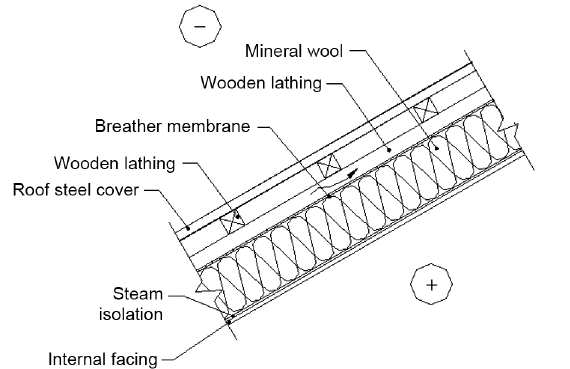
Fig. 2. Lightweight steel roof construction of experimental cell S1 Thermal transmittance coefficients of cell walls was 2 2 U wall = 0.18 W/(m ·K), cells floor U floor = 0.18 W/(m ·K) 2 and cells roof U roof = 0.16 W/(m ·K). Profiled dark